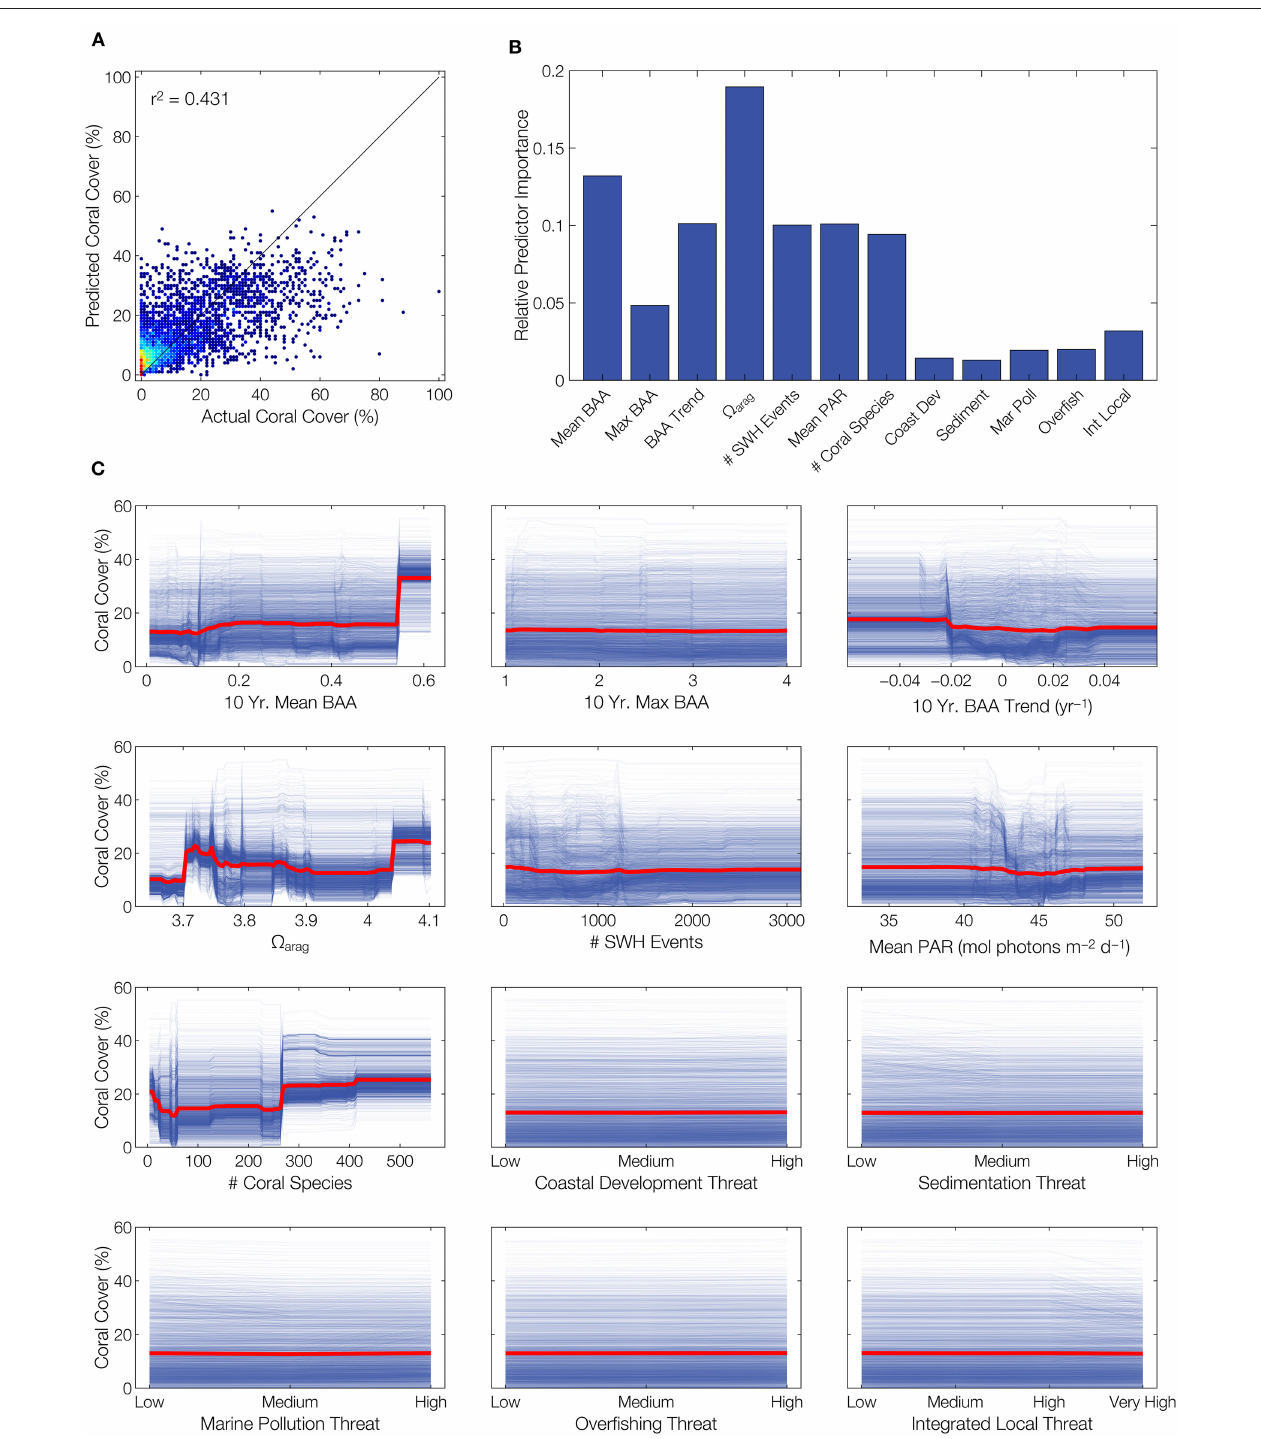
FIGURE 4 | Poor predictability of coral cover using combined biogeophysical forcing parameters. Of multivariate models fit to the data set, a bootstrap aggregated (bagged) ensemble regression tree provides the best predictions of coral cover. However, the model only explains 43% of the variability in coral cover, reinforcing the proposition that available data are insufficient for quantitative modeling of coral reef condition with respect to environment. (A) Model predictions vs. actual coral cover, with colors indicating point densities (blue is lower density, red is higher density). (B) Relative importance for each predictor in the multivariate model. (C) Partial dependence plots (red lines) and individual conditional expectation plots (blue lines) illustrating model prediction responses to each predictor variable.